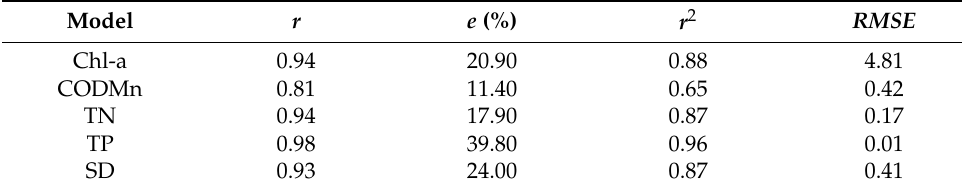
Table 4. Evaluation index of accuracy for the BP inversion model. Model